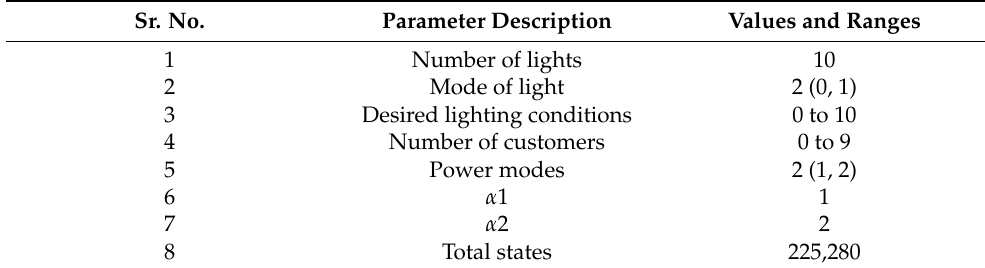
Table 3. Parameter values for lighting control. Sr.